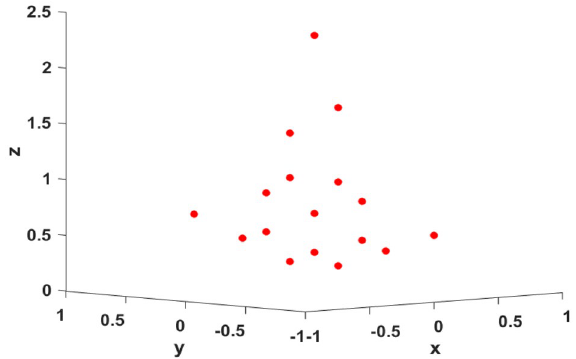
Figure 9. Ground truth.